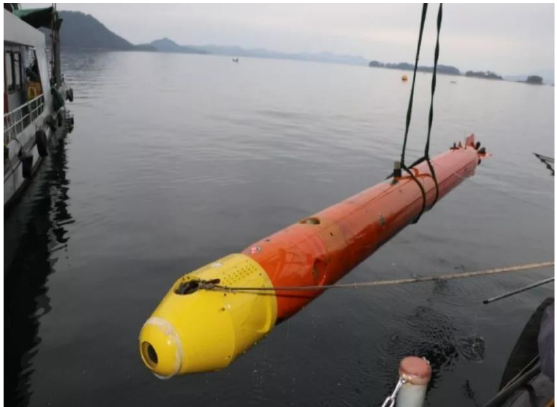
Figure 22. The SIA-3 AUV.